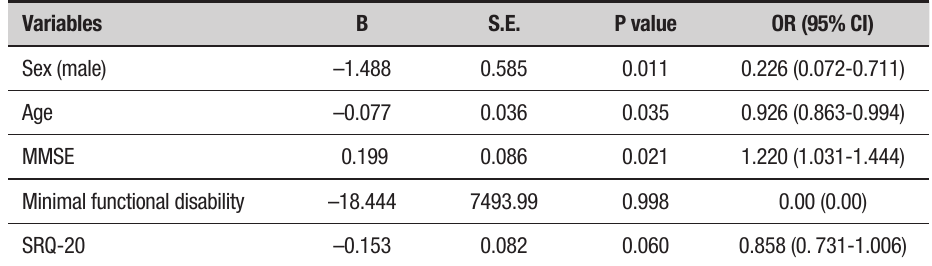
Table 2. Baseline predictors of successful aging during 16-year follow-up: multivariate logistic regression. Variables B S.E. P value OR (95% CI) Sex (male) –1.488 Age –0.077 MMSE